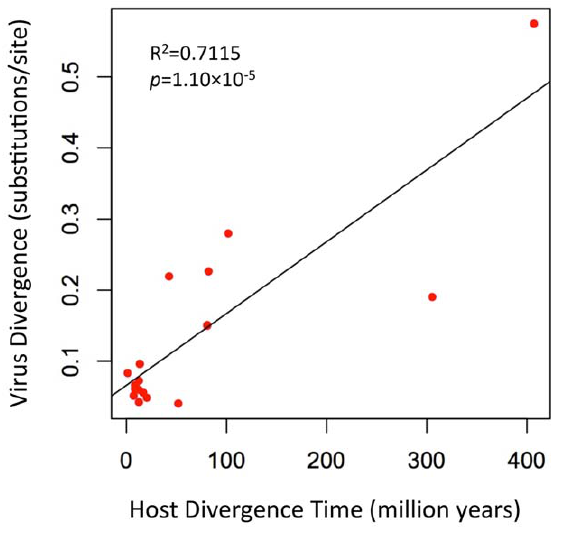
Figure 5. A plot of the correlation between foamy virus divergence and their vertebrate hosts’ divergence times. The plot depicts host branch length (in millions of years) versus virus branch length (in expected amino acid substitutions per site) for every branch (both internal and external). The virus branch lengths are derived from the virus tree in Fig.